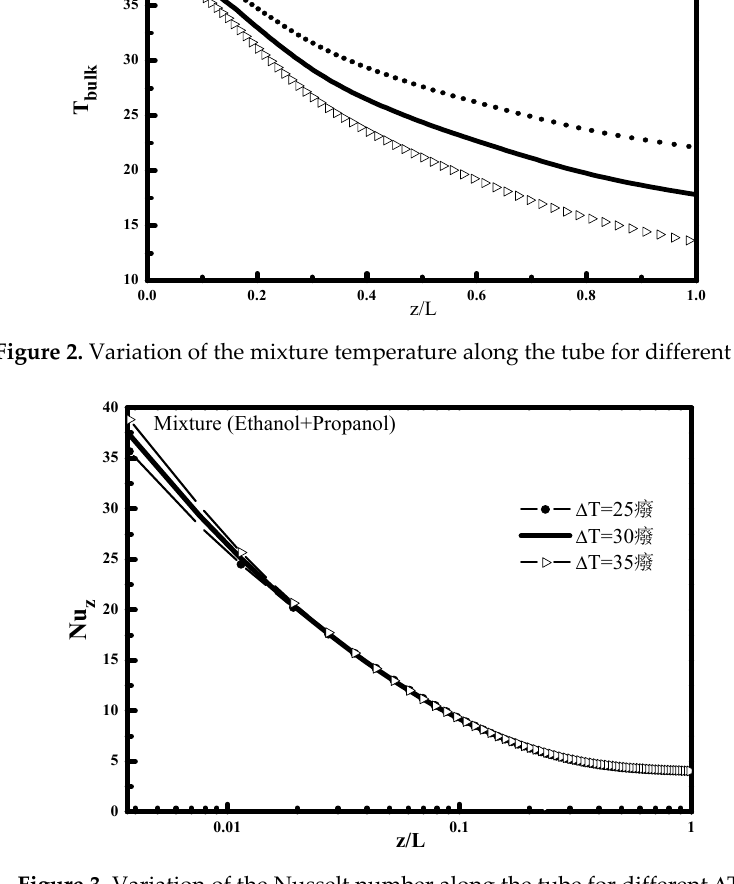
Figure 3. Variation of the Nusselt number along the tube for different Δ